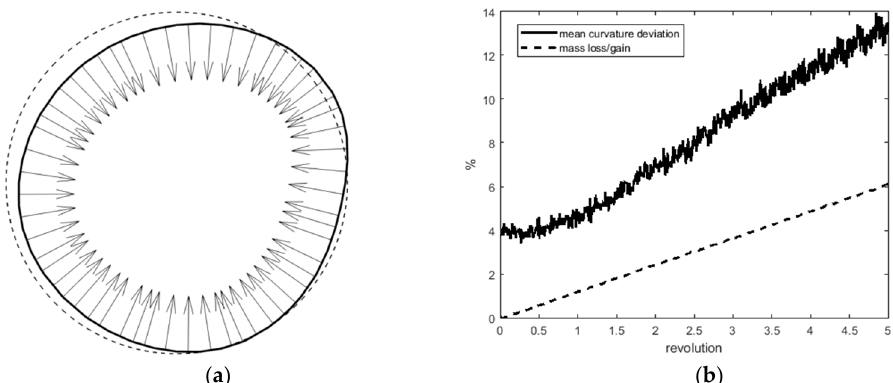
Figure 4. Five revolutions of a circle using a 50 × 50 structured mesh, using the direct method ( a ) An original circle before (dashed line) and after five revolutions (solid line). The normal vectors are shown after rotation, ( b ) The percentage of curvature deviation (solid line) and mass change (dashed line).